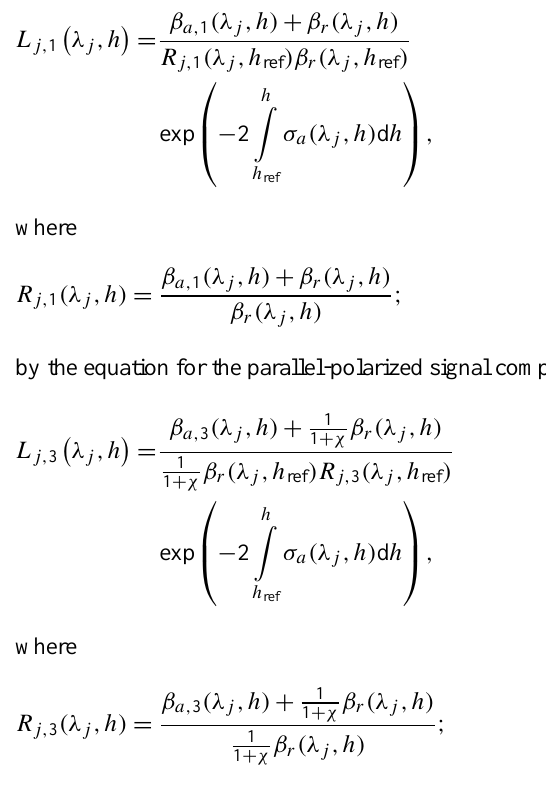
by the equation for the total backscatter